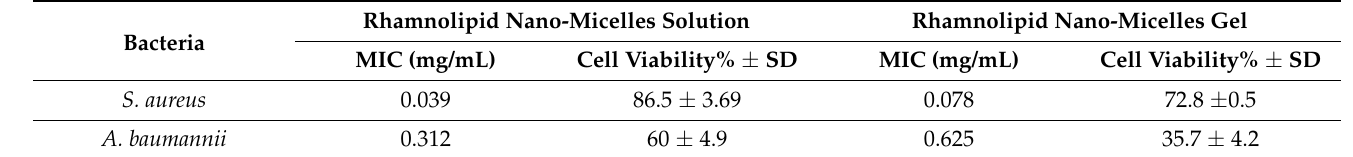
Table 2. MIC * values of rhamnolipid nano-micelle formulations recorded for S. aureus